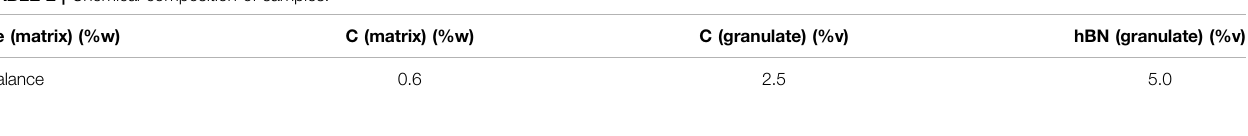
TABLE 2 | Chemical composition of